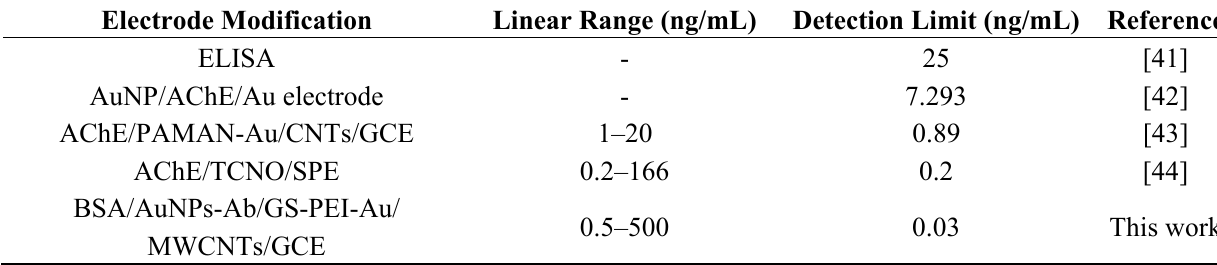
Table 1. Comparison of analytical methods for the detection of